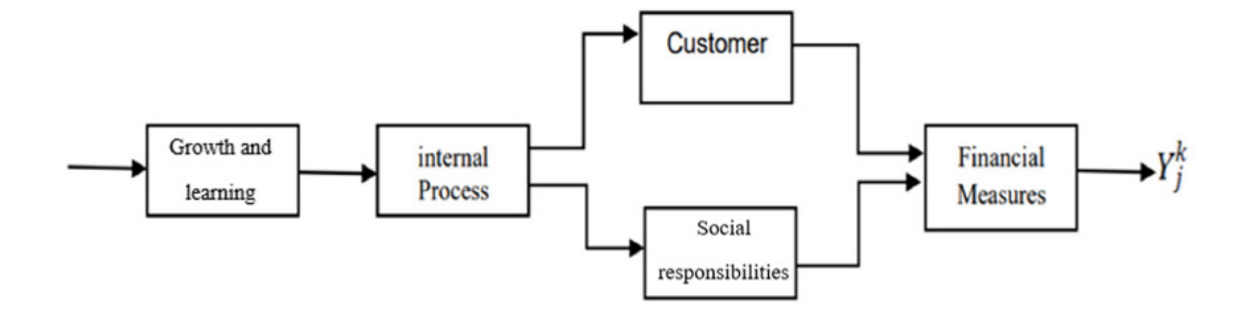
Figure 10. Network model of the BSC structure. If this model is used, then the findings are as shown in Table 9. Table 9. Serial evaluation